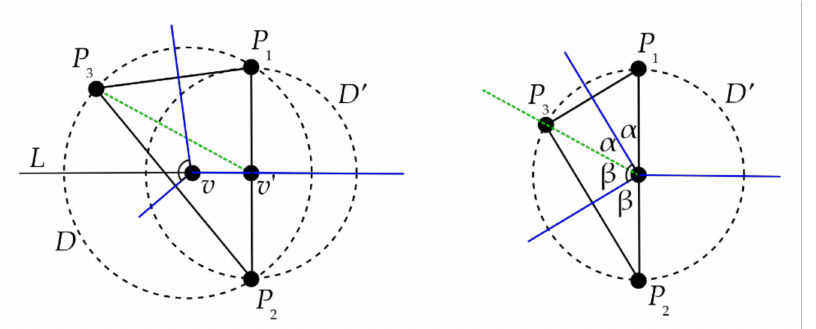
Figure 22. On the left, three blue edges from the Voronoi diagram meet at vertex v , with “seeds” P 1 , P 2 , and P 3 , such that P 1 P 2 , P 1 P 3 , and P 2 P 3 are edges in the Delaunay triangulation. In the proof below, P 3 slides along the green line until it reaches the boundary of the disk D’ , which also moves v to v’ and moves D to D’ ; the result is pictured on the